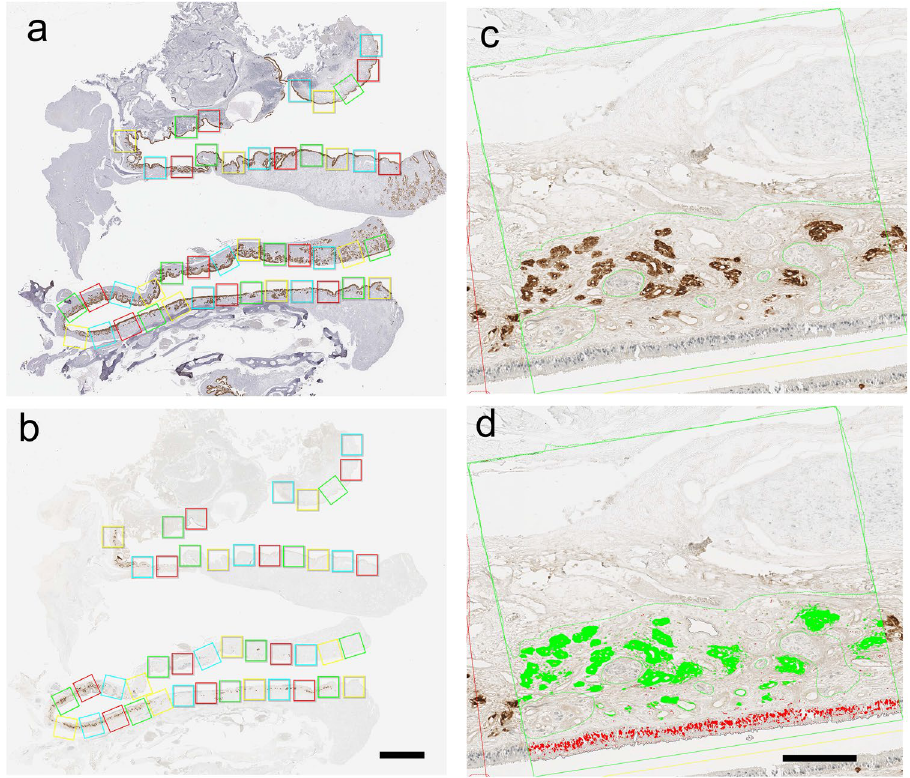
Figure 4. Quantitative image analysis of the area for PGP9.5 and LCN15 immunoreactivity in the olfactory cleft mucosa. ( a ): Olfactory cleft mucosal lining with intact epithelium was morphologically identified using sections stained for cytokeratin 18. Using these sections, rectangle areas (1 × 1 mm) for analysis were serially set along the mucosal lining. ( b ): The same rectangular areas used in a were set on the serial sections stained for PGP9.5 and LCN15 for analysis. ( c ): A magnified view of the image in b . The immunoreactivity for PGP9.5 and LCN15 is visualized in gray and brown colors, respectively. ( d ): Areas of PGP9.5 and LCN15-immunoreactivity in each analysis area were automatically selected and marked in red (PGP9.5) and green (LCN15), respectively, by setting the color threshold. Scale bars in B and D are = 2 mm and 200 μm,